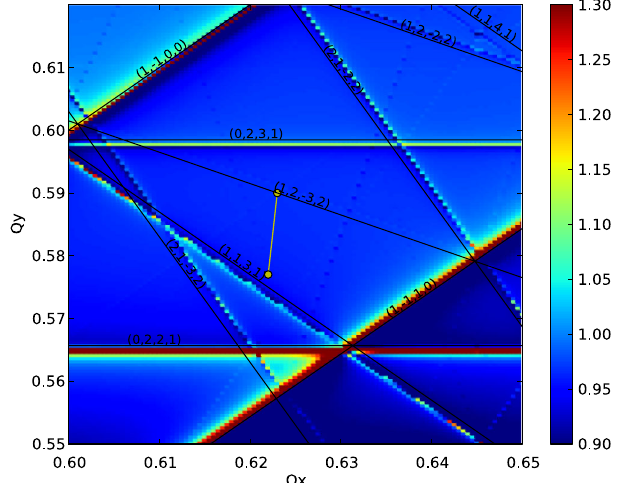
FIG. 7. Simulated tune scan based on a lattice model that includes magnet misalignments and corrector magnet settings determined according to our emittance tuning procedure. The yellow line shows how the coherent tunes increase as a bunch decays from 1 : 3 (cid:3) 10 11 down to 1 : 6 (cid:3) 10 9